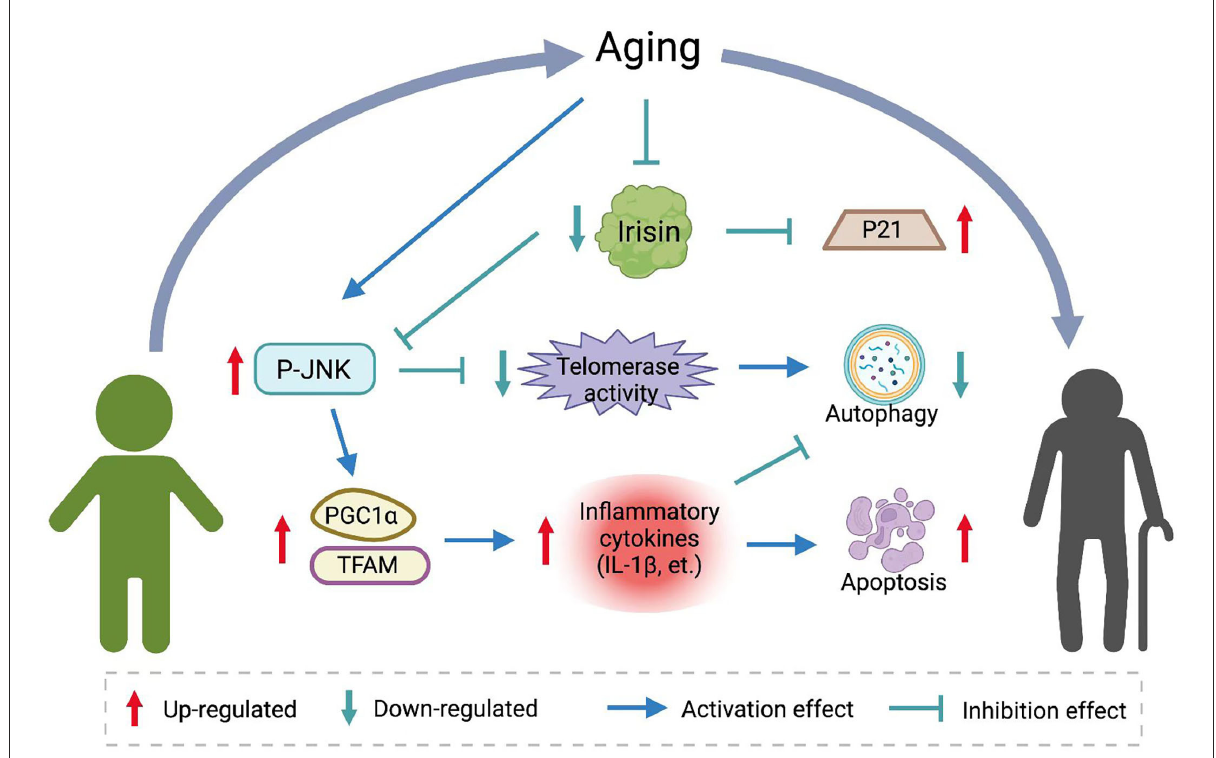
FIGURE2 The role of irisin in aging resistance. Aging reduces baseline levels of irisin in vivo . Irisin inhibits JNK phosphorylation and affects telomerase activity and expression of inflammatory factors. Induces autophagy and apoptosis resistance and decreases markers of